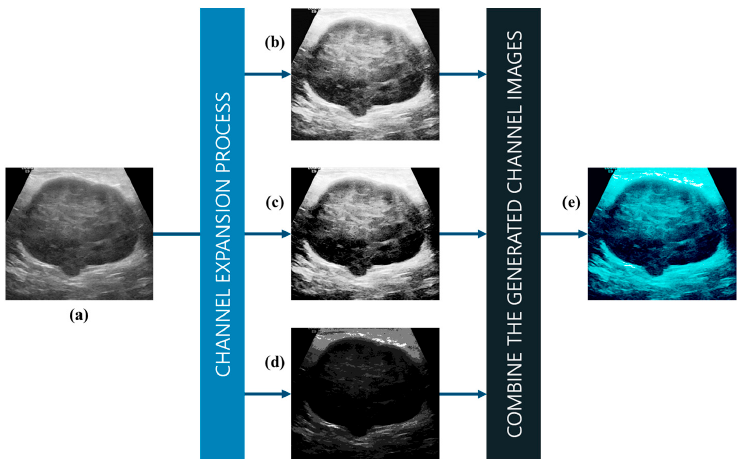
Figure 7. Expanded channel image creation process. ( a ) original image, ( b ) histogram equalization, ( c ) adjusting the brightness range, ( d ) simplified brightness rang, ( e ) result image